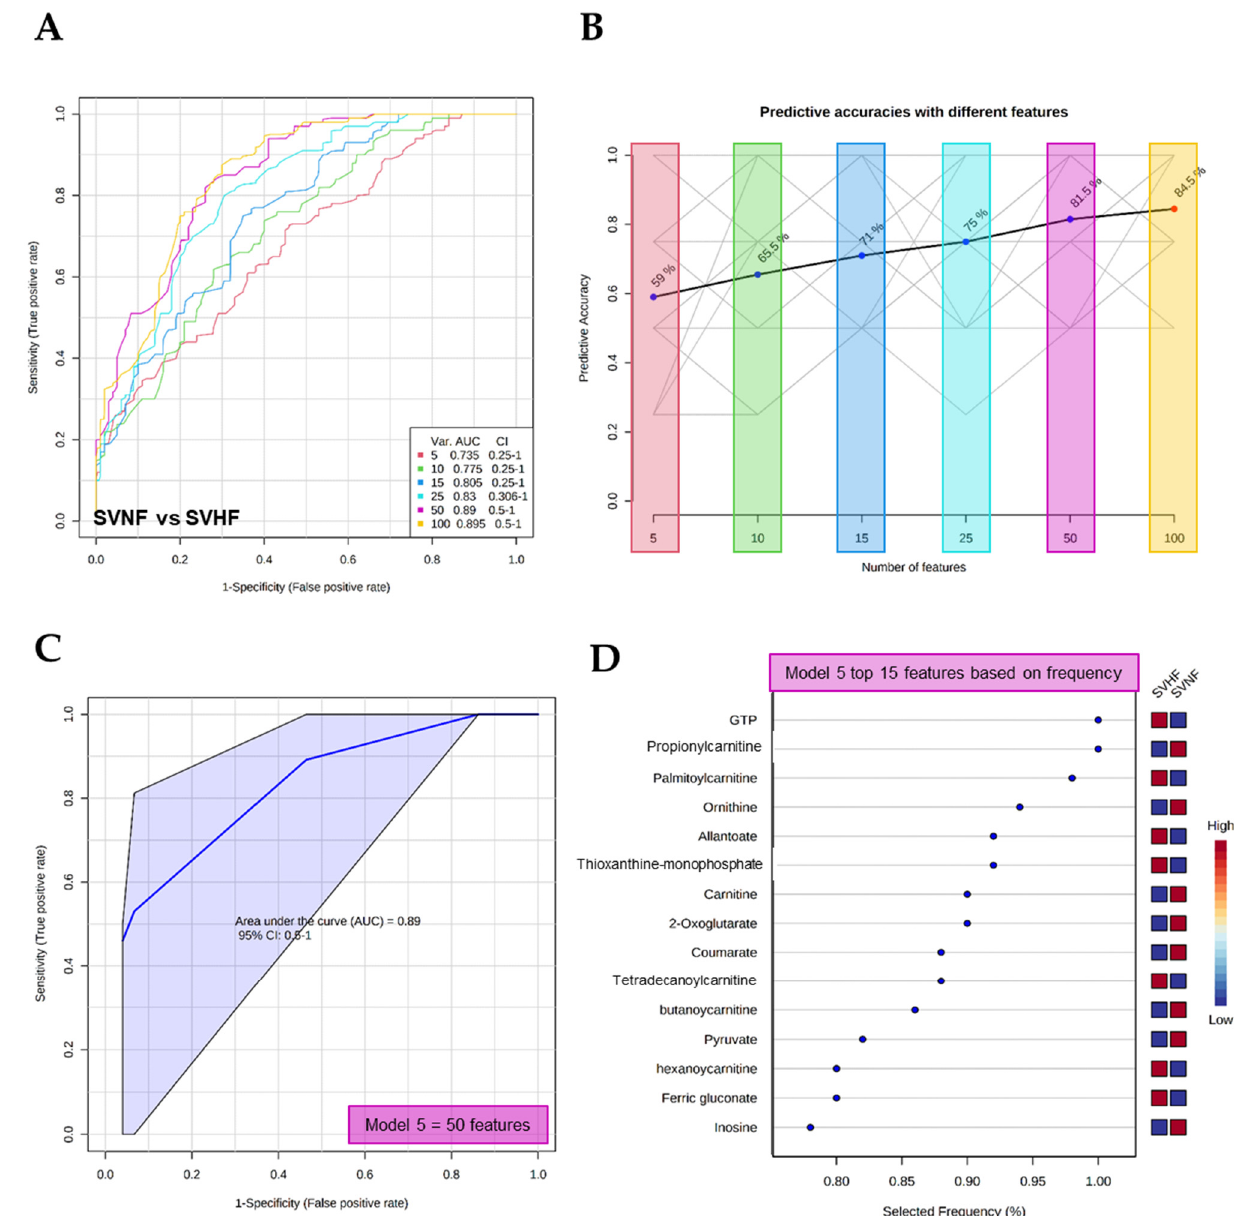
Figure 7. Multivariate analysis-based diagnostic potential of metabolomic profiles to distinguish SVNF from SVHF subjects. ( A ) ROC curves based on cross-validation (CV) performance (curves are from all models averaged from all CV runs). ( B ) The predictive accuracy of each model based on the total number of metabolite features included in the model, from 5 to 100. ( C ) A specific ROC curve (Model 5) demonstrating the AUC and 95% confidence interval (CI). ( D ) The top 15 metabolite features, based on frequency, used for the predictive model (Model 5).